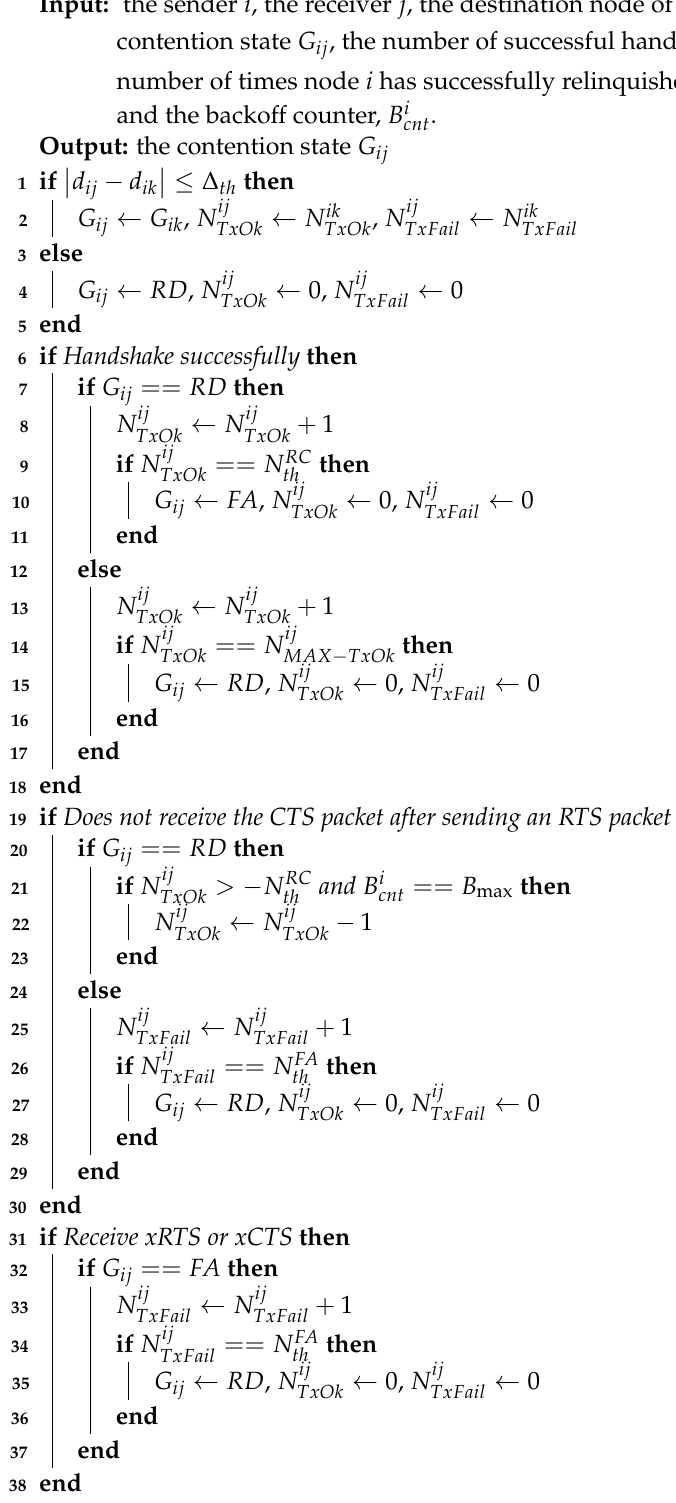
Algorithm 2: Contention window state update